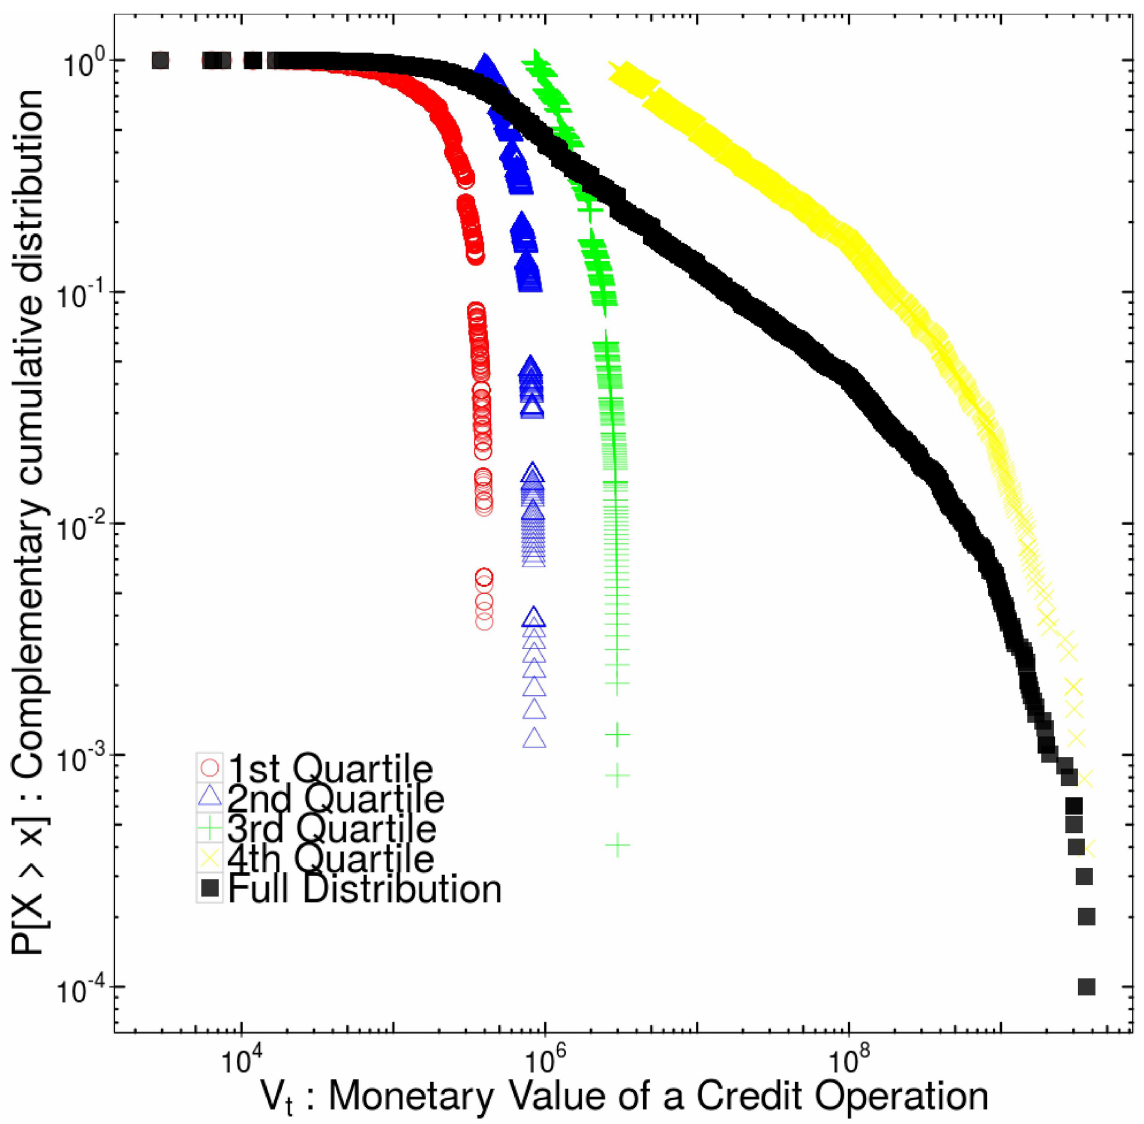
Fig 2. Demonstration of heterogeneity in the value of credit operations. This figure shows the complementary of the cumulative distribution function of the value of credit operationsin log-logscale. The distribution of value of credit operationsis highlyskewed to the upper quartile of the